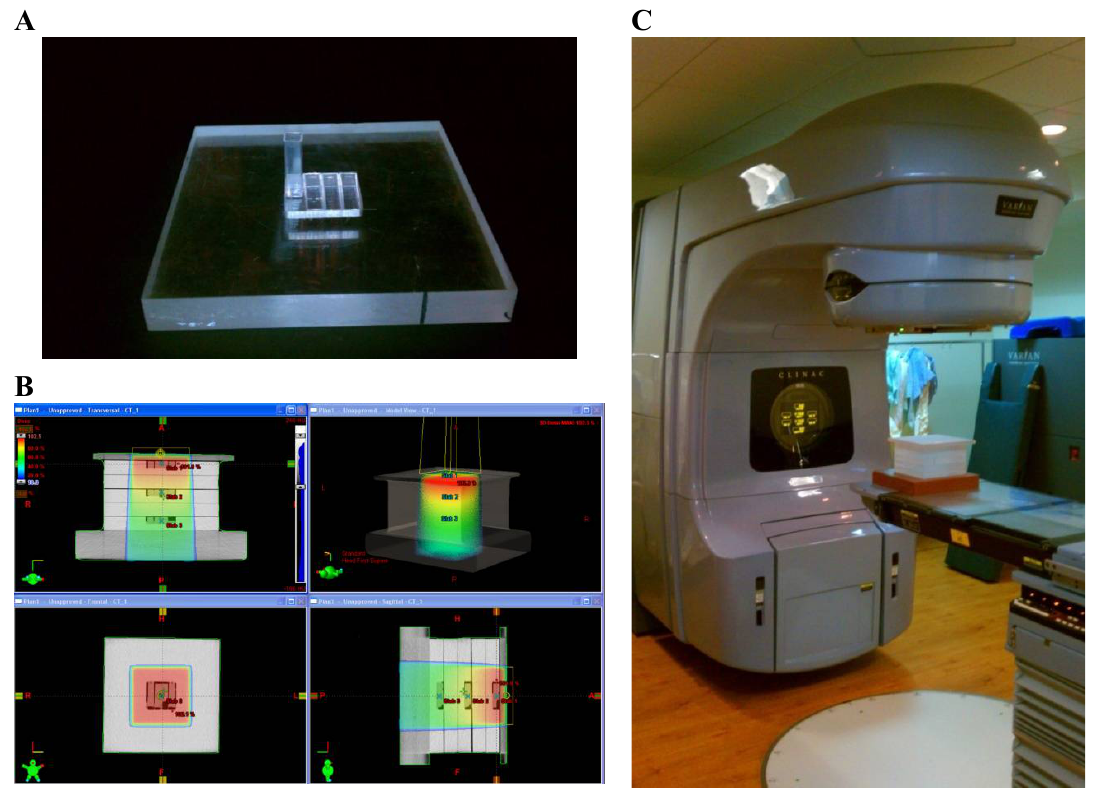
Figure 2. ( A ) Polystyrene phantom plate with void for irradiation of cuvettes; ( B ) dose calculation of phantom (heat map represents relative dose); ( C ) medical linear accelerator used for irradiations.